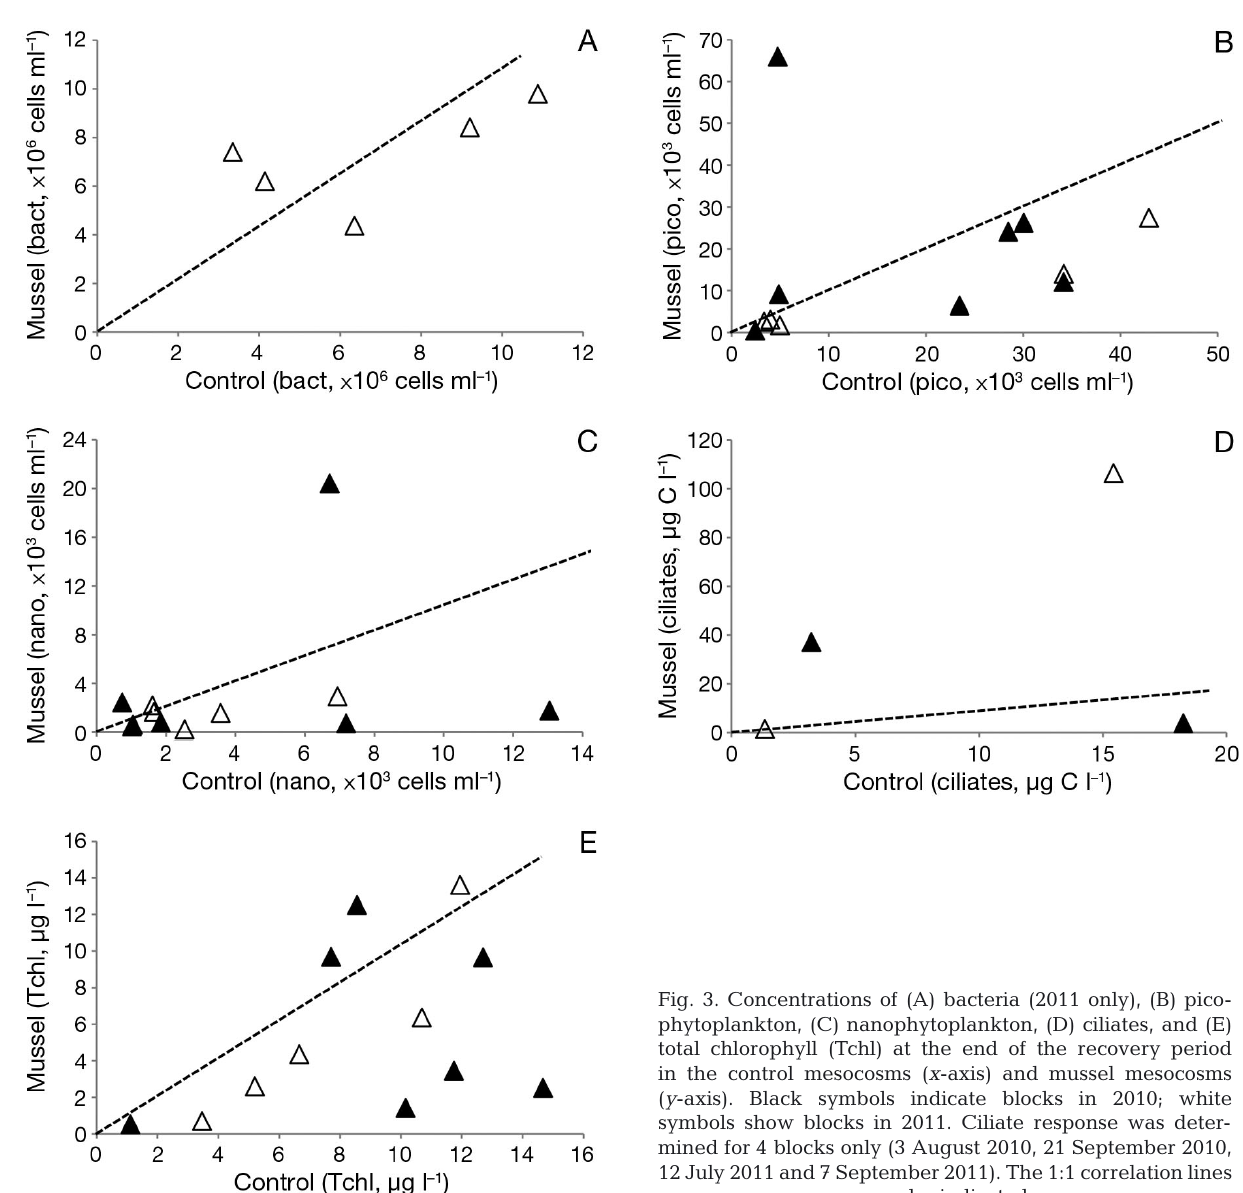
Fig. 3. Concentrations of (A) bacteria (2011 only), (B) pico- phytoplankton, (C) nanophytoplankton, (D) ciliates, and (E) total chlorophyll (Tchl) at the end of the recovery period in the control mesocosms ( x -axis) and mussel mesocosms ( y -axis). Black symbols indicate blocks in 2010; white symbols show blocks in 2011. Ciliate response was deter- mined for 4 blocks only (3 August 2010, 21 September 2010, 12 July 2011 and 7 September 2011). The 1:1 correlation lines are also